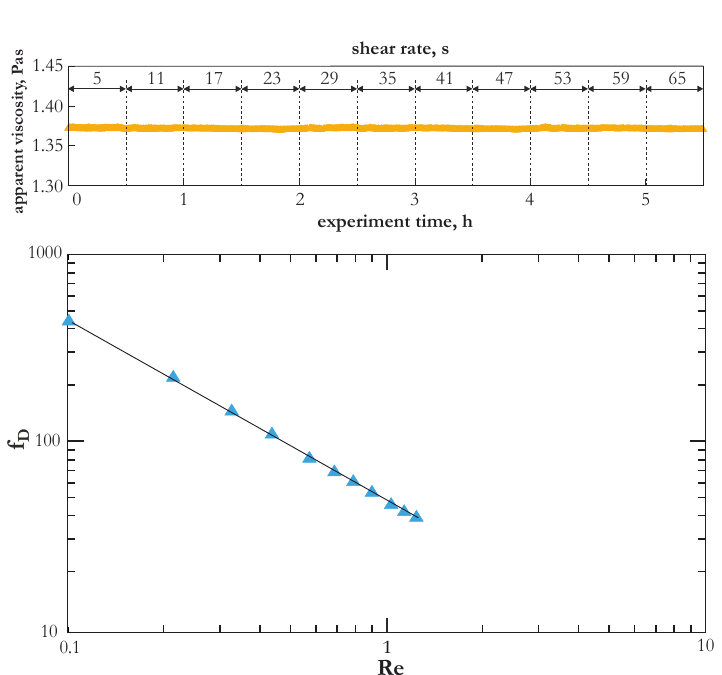
Figure 3. Viscosity of 99.5% glycerol across shear rate range from 5 s − 1 to 65 s − 1 and Blasius plot f D = f ( Re ) prepared on the base of rheological data obtained during flow experiment in capillary- pipe viscometer at 21